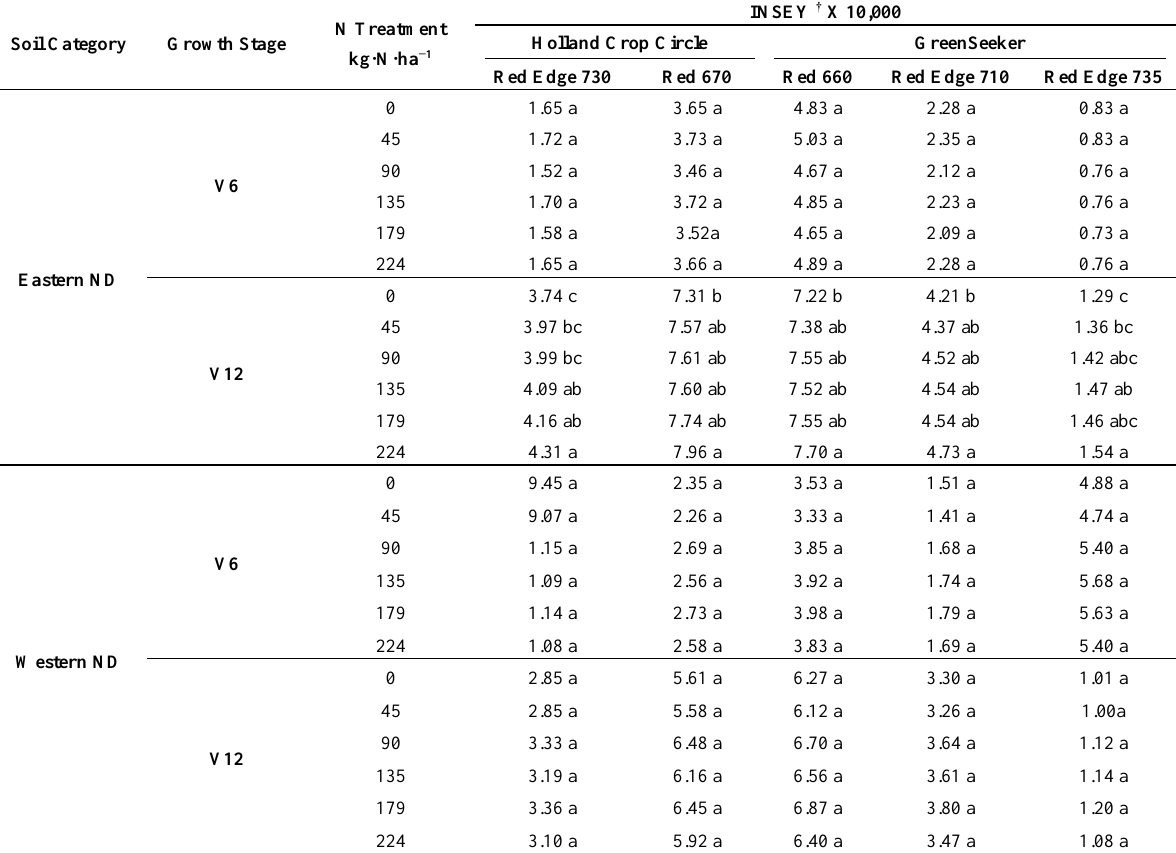
Table 7. Treatment differences between INSEY developed from five wavelengths utilizing two ground-based active-optical sensors in eastern North Dakota (ND) ( n = 47) and western ND no-till ( n = 95) systems at two corn growth stages from nitrogen rate